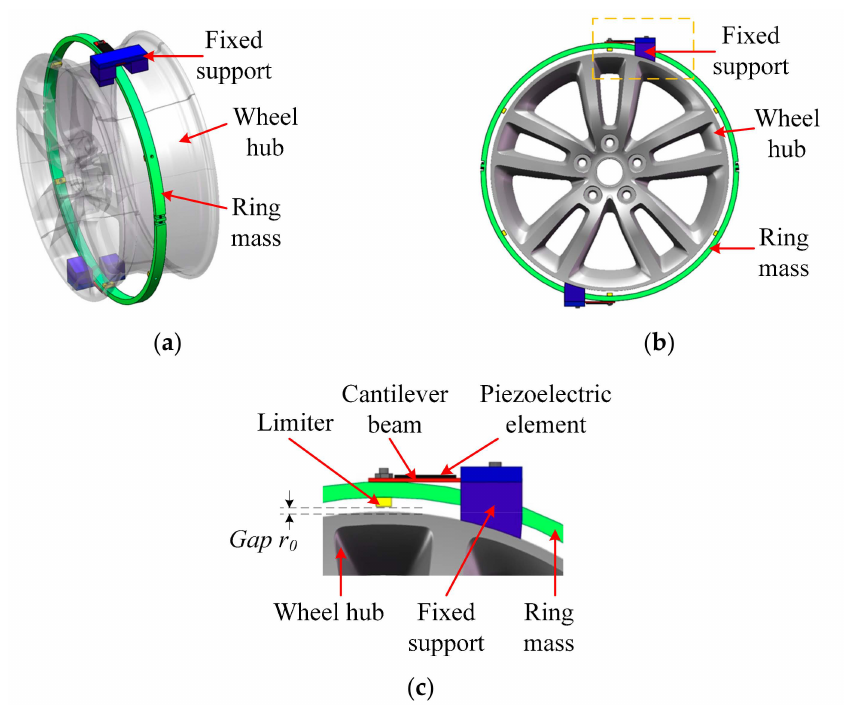
Figure 3. Structure of wheel and the rotational energy harvester: ( a ) three-dimensional view; ( b ) front view; ( c ) close view.